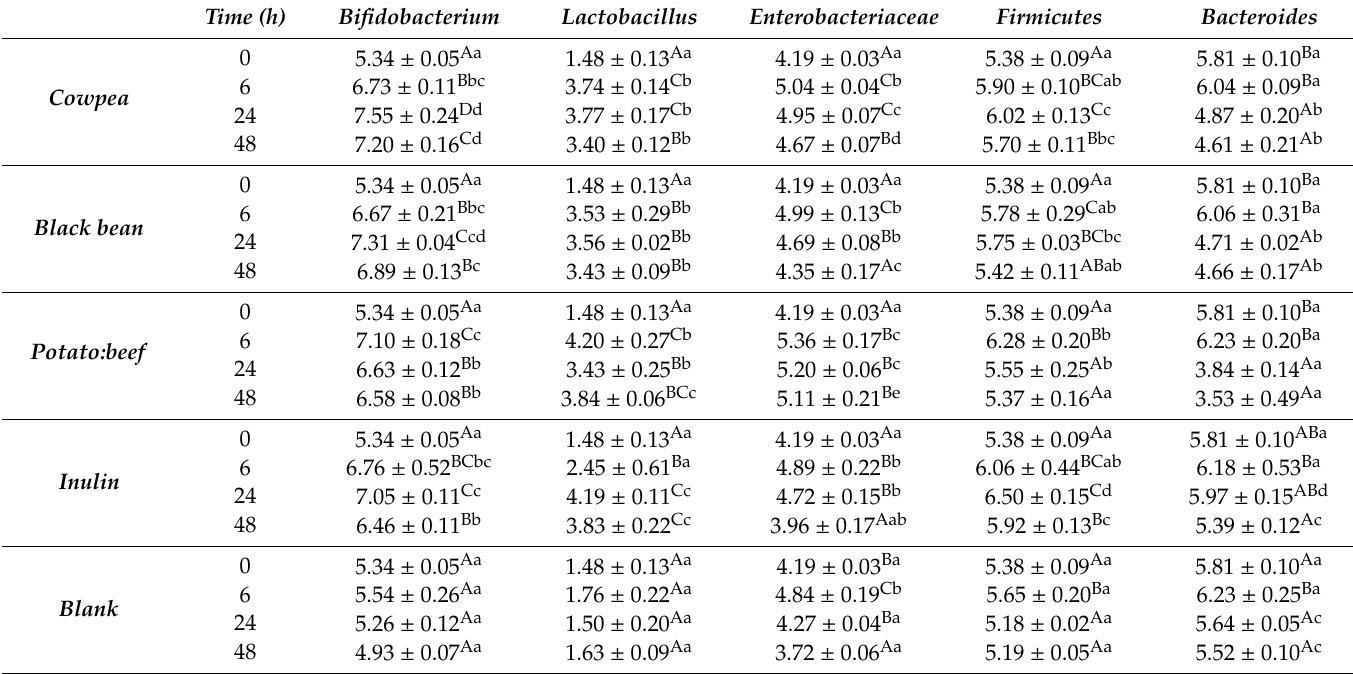
Results are expressed as log genome equivalent per mL and presented as mean ± SD from four replicates ( n = 4). The data marked by the same letters were not significantly di ff erent ( p > 0.05). Di ff erent uppercase letters for comparison within each fermentable source at a di ff erent time and lowercase letters for comparison within the di ff erent fermentable source at the same time, indicating significant di ff erences at p <